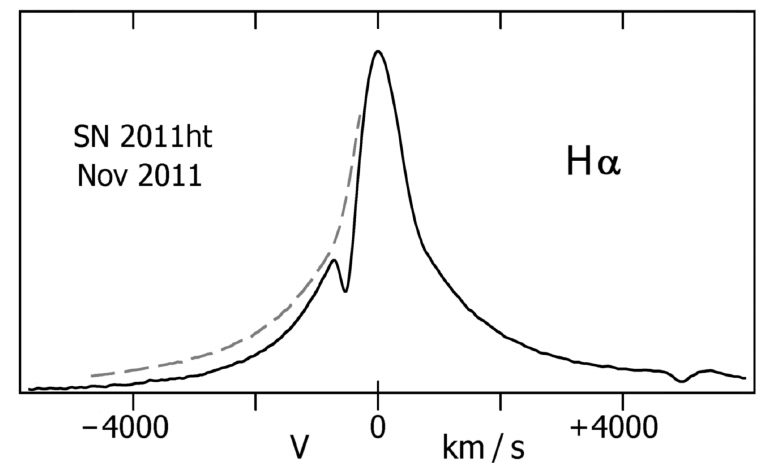
Figure 6. Emission line profile with moderate Thomson scattering. The dashed curve on the left side is a mirror image of the right side. Note that the line wings extend far beyond the velocity indicated by P Cyg absorption. This example is H α in the radiation-driven outflow of SN 2011ht [42], but other giant eruptions produce similar line